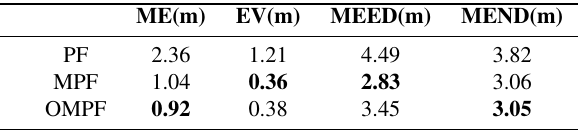
Table 2: Comparisons of navigation performance for PF, MPF, and OMPF.